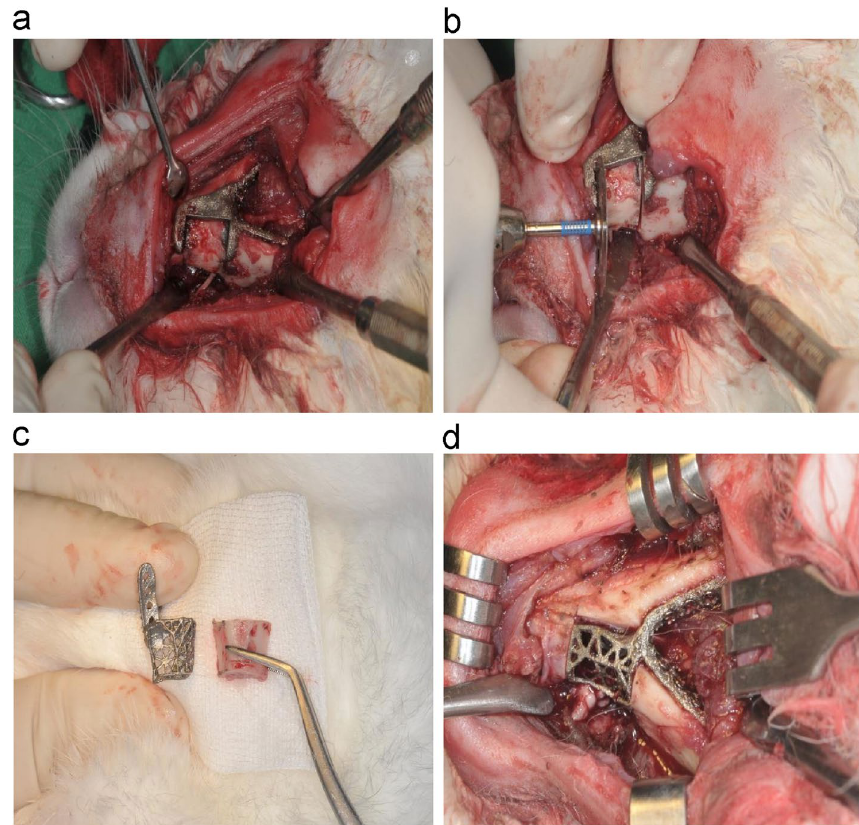
Fig. 2 Animal surgery. a fixation of the bone resection guide and marking of the bone resection border (pencil); b bone resection using a disk; c resected bone fragment and printed implant; d positioning and fixation of the